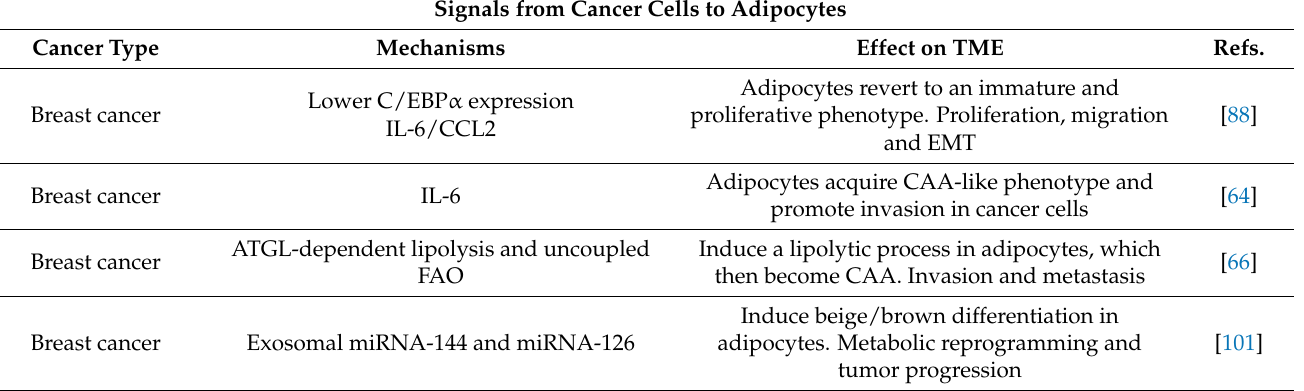
Table 3. Paracrine communication between cancer cells on adipocytes and macrophages in the tumor